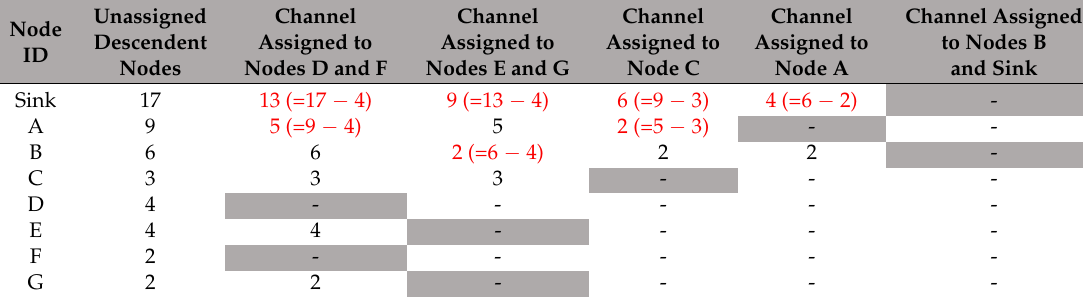
Table 2. The number of descendant nodes to which channels are not allocated according to channel